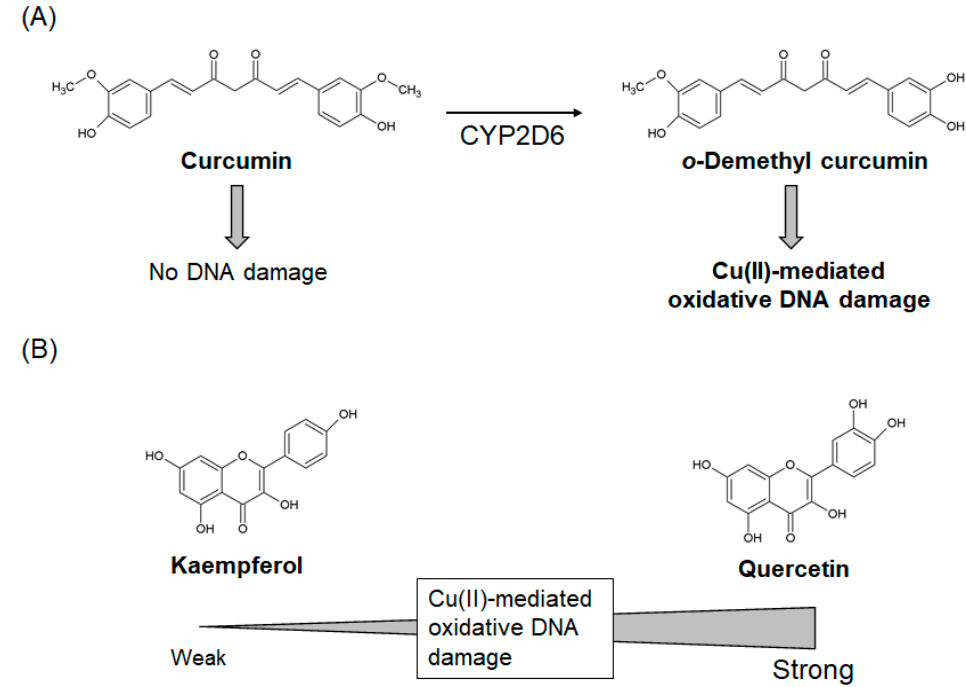
Figure 4. The role of catechol moieties in o -demethyl curcumin- and quercetin-mediated oxidative DNA damage in the presence of Cu(II). ( A ) o -Demethyl curcumin (with a catechol moiety) induced Cu(II)-mediated oxidative damage, while curcumin, its parent compound (without catechol moieties), did not. ( B ) Quercetin (with a catechol moiety) induced stronger oxidative damage than kaempferol, its analog (without catechol moieties) in the presence of Cu(II). CYP: cytochrome P450